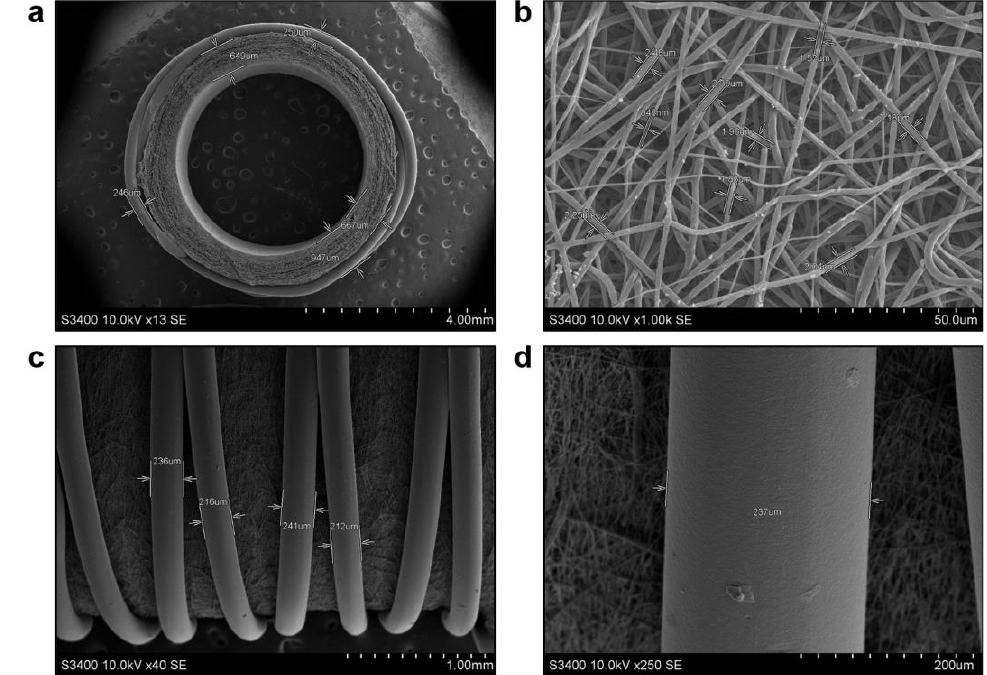
Figure 1. Electron microscopy examination of electrospun PCL Ilo/CAD TEVGs before their implantation. ( a ) Tubular scaffold with a highly porous wall and anti-aneurysmatic PCL sheath, ×13 magnification, scale bar: 4 mm; ( b ) Graft wall consisting of micro- to nanoscale fibers and interconnected pores, ×1000 magnification, scale bar: 50 µm; ( c ) Large, continuous and partially crossed filaments of an anti-aneurysmatic PCL sheath, ×40 magnification, scale bar: 1 mm; ( d ) A close-up of the filament within an anti-aneurysmatic PCL sheath, ×250 magnification, scale bar: 200 µm. Accelerating voltage: 10 kV.